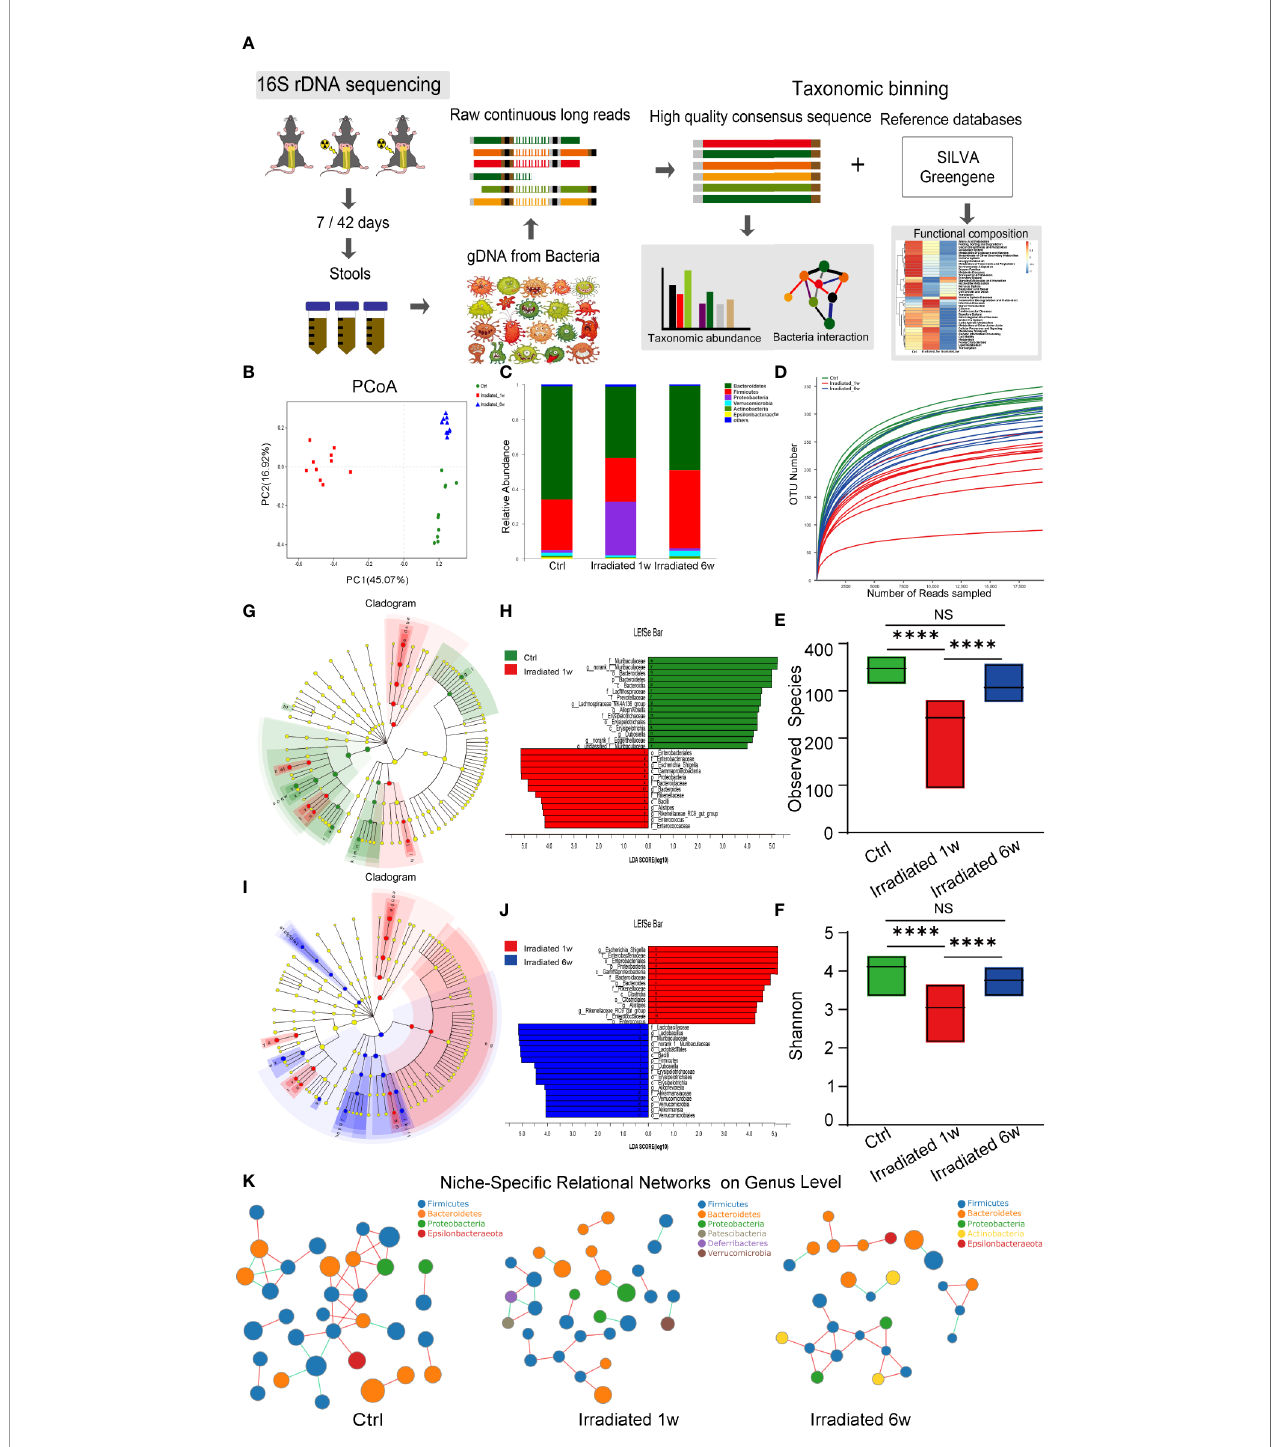
FIGURE 3 | Dynamic characteristics of the gut microbial pro fi le in RE mice. (A) Work fl ow of the 16S rDNA sequencing and data analysis. (B) PCoA scores plot based on OTU level. (C) Relative abundance of the top 10 dominant bacteria at the phylum level. (D) OUT number, (E) observed species number and (F) Shannon diversity index of intestinal bacteria among groups. (G, J) LEfSe analysis for genomic features of gut microbiota expressed by taxonomic cladograms (G, I) and liner discriminant analysis (H, J) based on OTU abundance. Circles irradiated from the inside to the outside represent the classi fi cation levels from phylum to genus. (K) Niche-speci fi c relational networks in the genus level in irradiated and unirradiated groups. The size of the nodes in the fi gure indicates the genus abundance, and different colors represents different phylum of genus; the colors of the lines indicates positive and negative correlation, red indicates positive correlation, and green indicates negative correlation. The more lines, the closer relationships between one genus and others. Signi fi cance levels are indicated as follows: ****q < 0.0001; NS q >